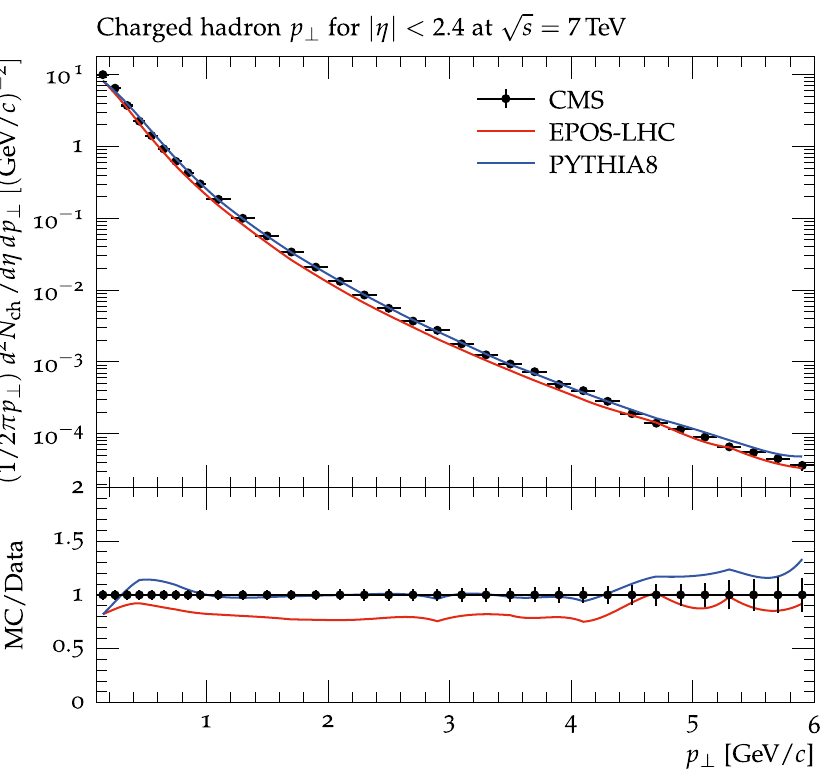
Figure 2. The p T spectrum of charged hadrons at η < 2.4 measured by the CMS experiment compared with the prediction of the EPOS and Pythia models. Solid black markers represents the experimental measurements while lines of different colors show the models’ predictions. A blue line shows the Pythia prediction while the red line represents the EPOS model